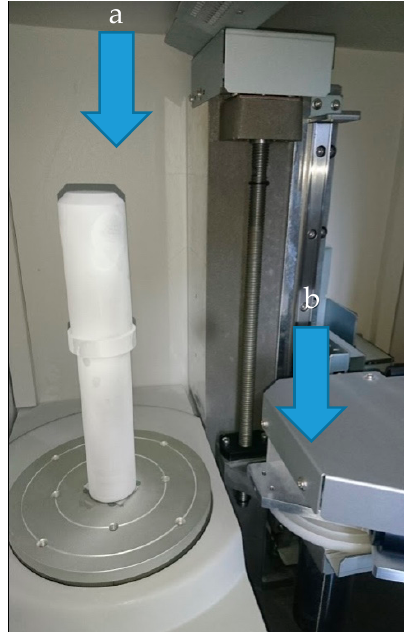
Figure 3. Experimental setup—shaft prepared for scanning; ( a )—scanned object, ( b )—scanning head.